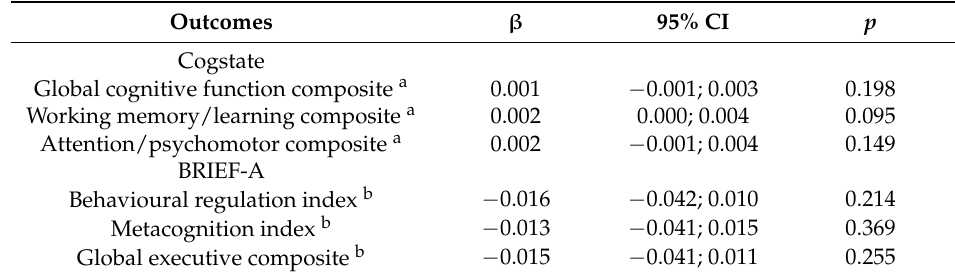
Table 2. Associations between plasma selenium concentration and cognitive outcomes in 154 older adults.